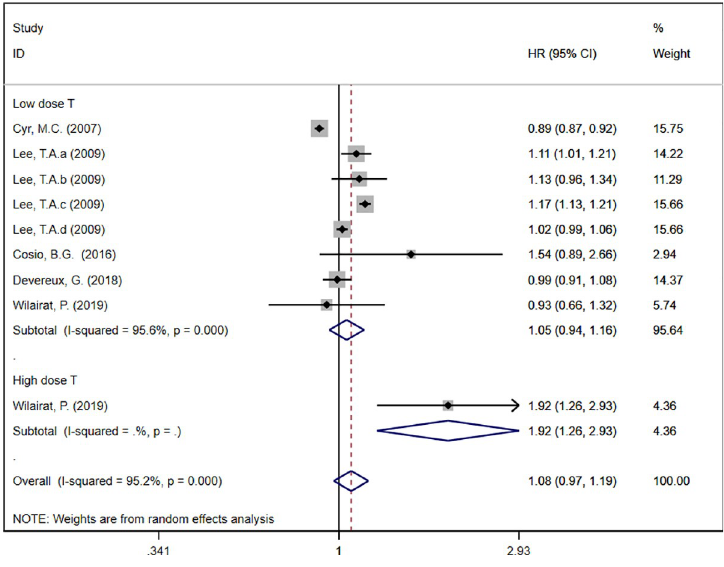
Fig 2. Forest plot of acute exacerbation rate (Subgroup analysis based on the dose of theophylline).